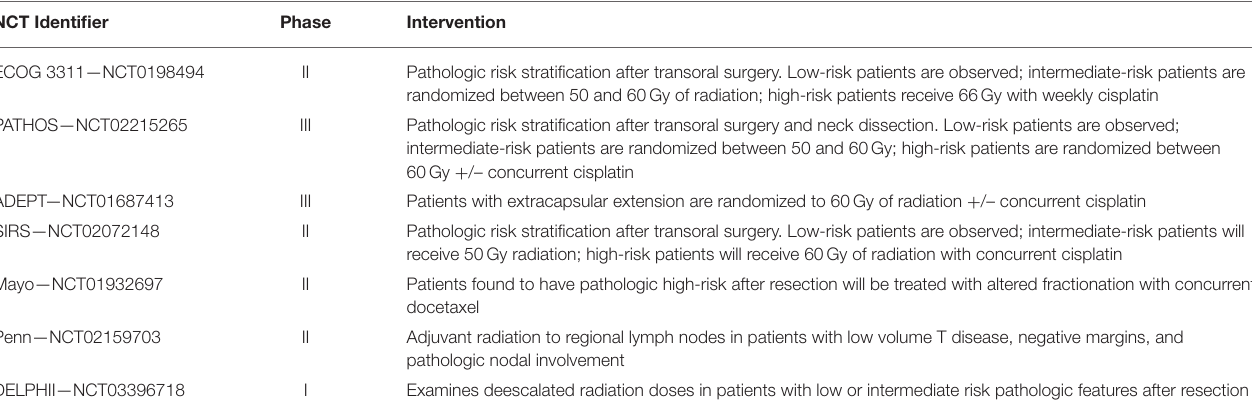
TABLE 1 | Summary of selected HPV de-escalation studies in the adjuvant setting.